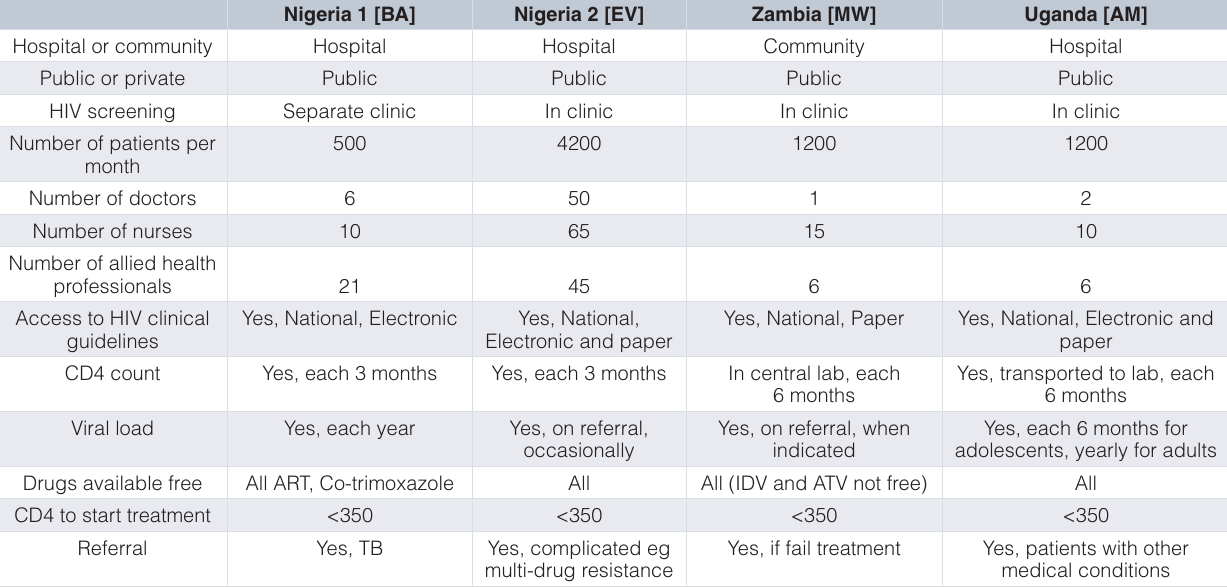
Table 1. Characteristics of the 4 participating